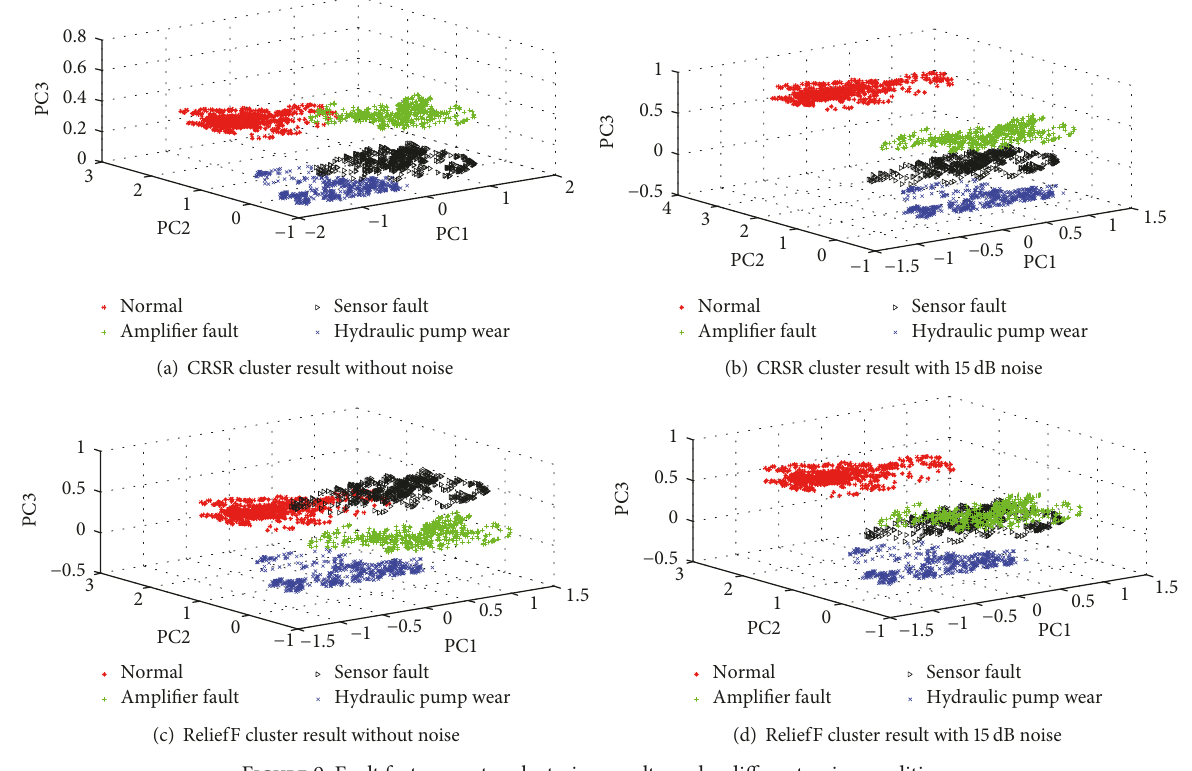
Figure 9: Fault feature vector clustering results under different noise